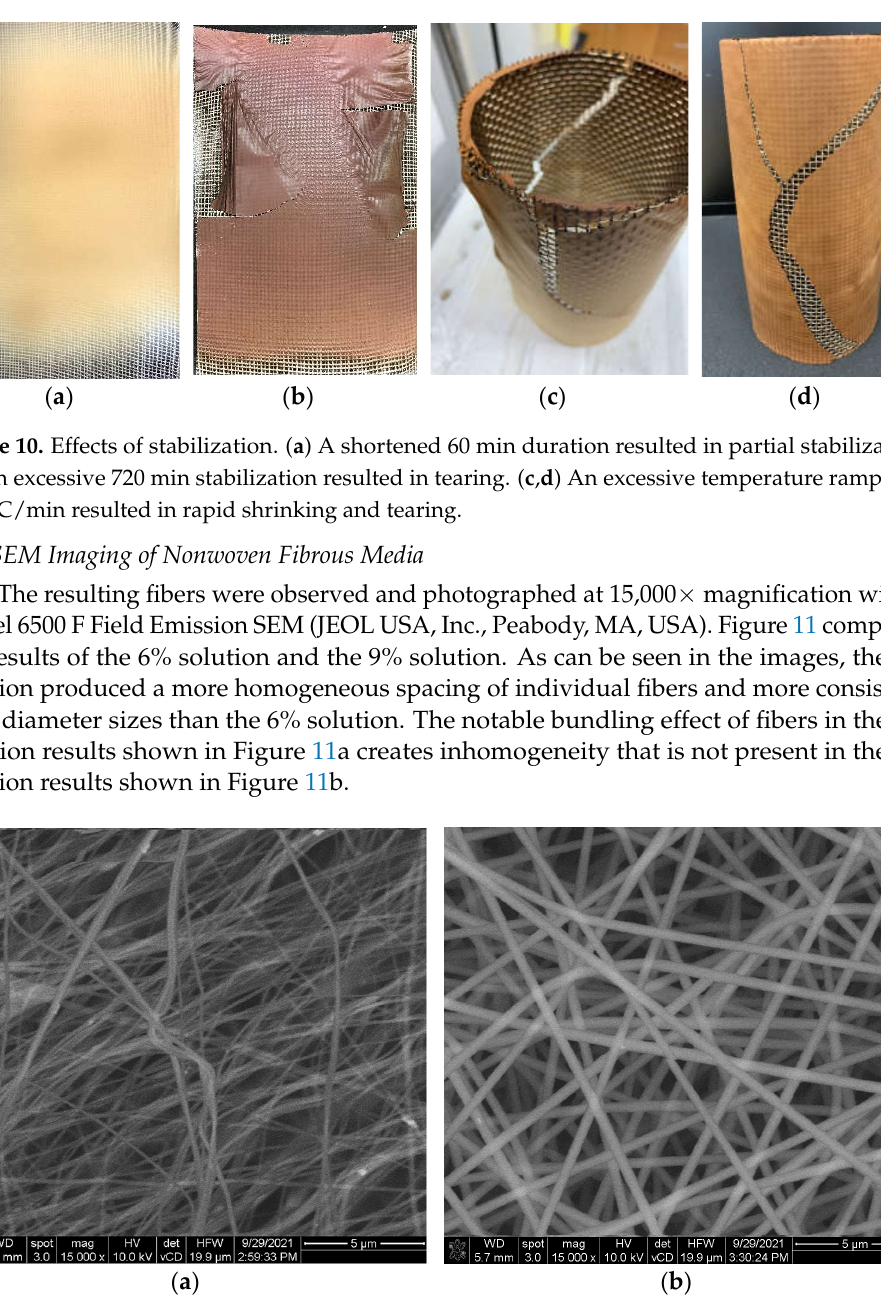
Figure 9. Comparison of as-spun media with stabilized media. ( a ) Side-by-side comparison for trial #6 (as-spun) and trial #5 (after stabilization). ( b ) Close up view of as-spun polyacrylonitrile fibers.